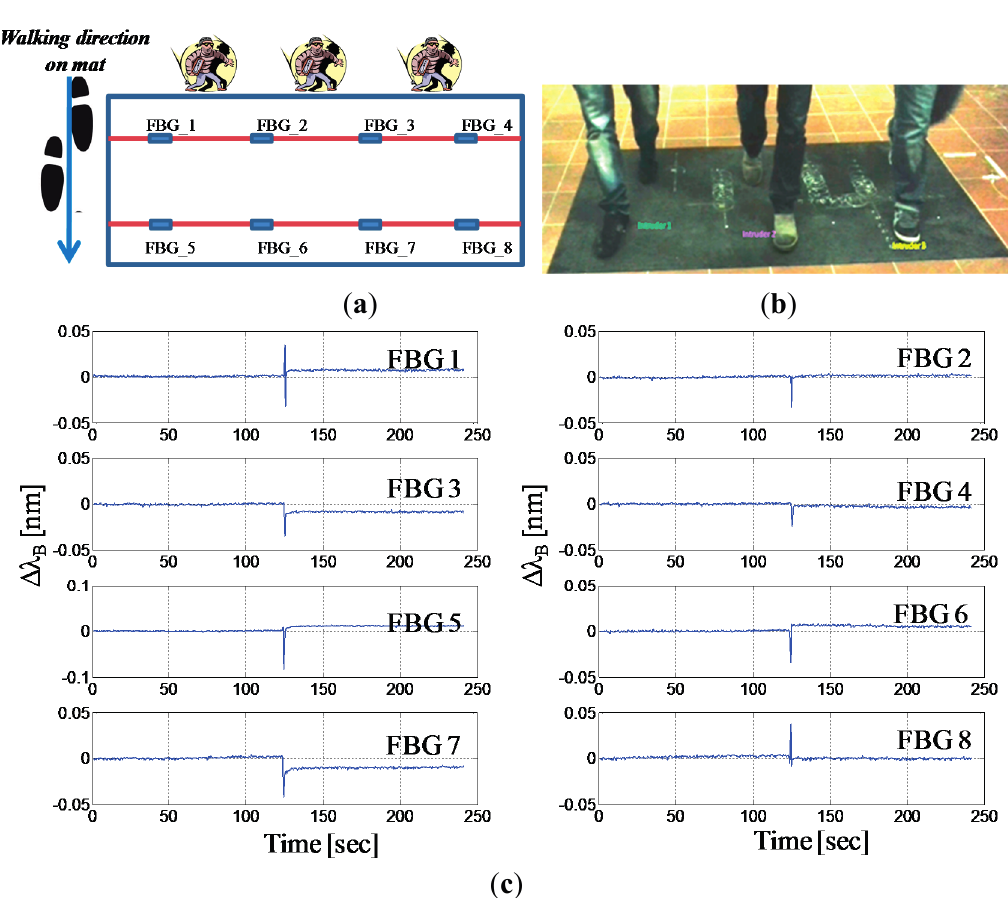
Figure 9. ( a ) Schematic of the intruder’s crossing pattern; ( b ) Photo of the walking test on the mat; ( c ) Bragg wavelength shift versus time for the eight